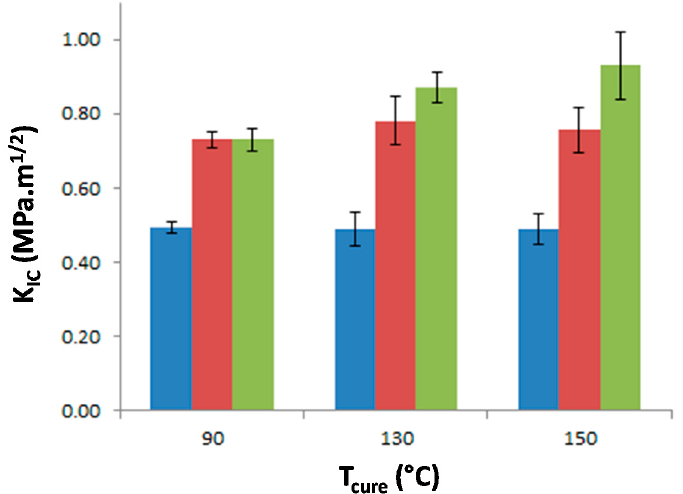
Figure 9. Stress intensity factor, K IC , of neat epoxy network and PES-based blends as a function of the curing temperature. Blue: neat epoxy; Red: f-PES based blend; Green: nf-PES based blend.